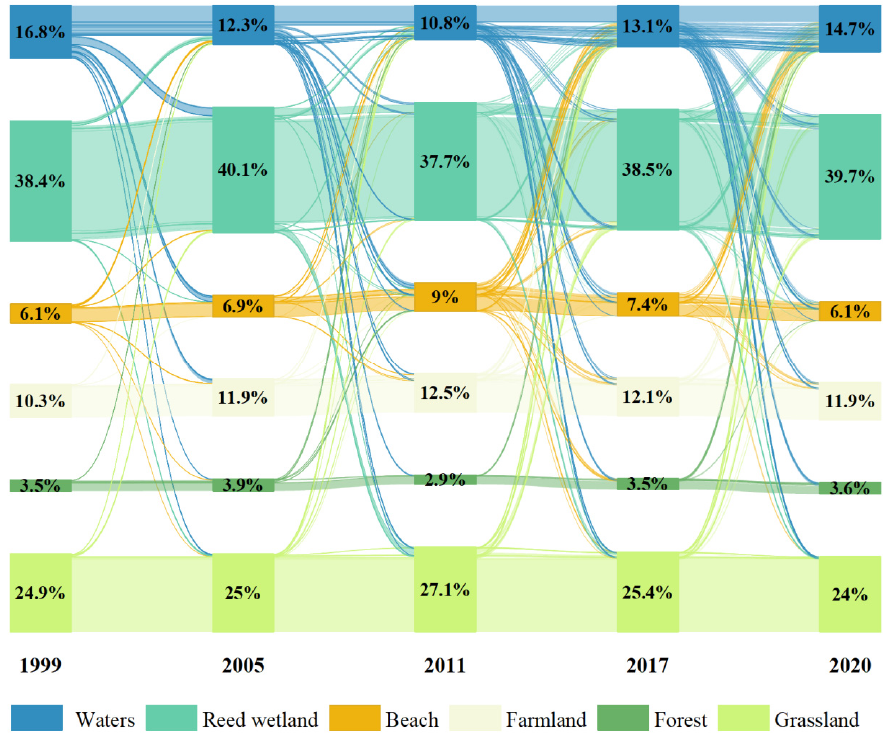
Figure 3. Accumulation map of wetland area in different periods from 1999 to 2020 (the color of the line is consistent with the type of land use, the left side of the line connects the original land use and the right side connects the direction of land use transfer).